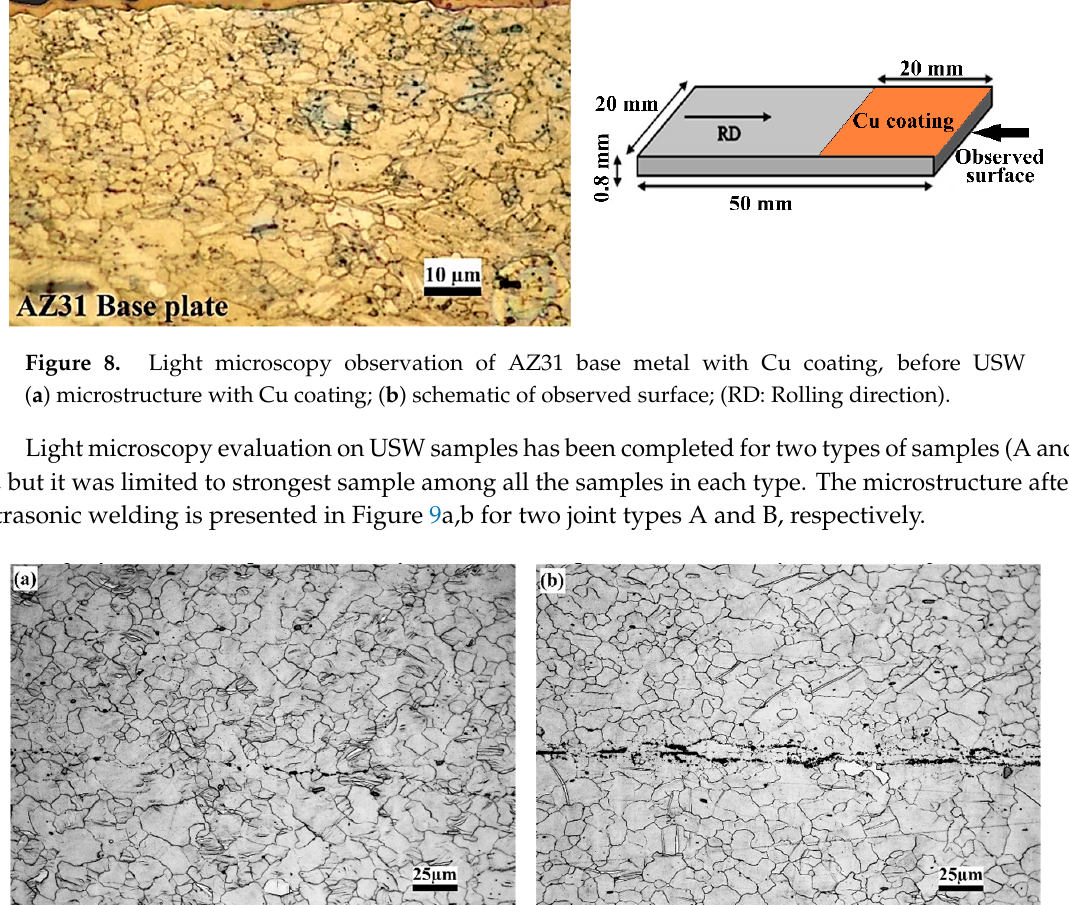
Figure 9. Light microscopy microstructure of interface flat region: ( a ) joint type A (1400 J); (b) joint type B (1100 J).